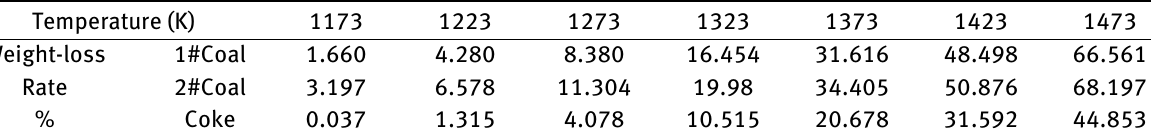
Table 3: Weight-loss rate of pulverized coal and coke separately at different temperatures Temperature (K)